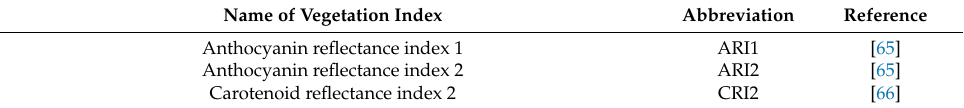
Table 2. Select list of hyperspectral vegetation indices and abbreviations used in final